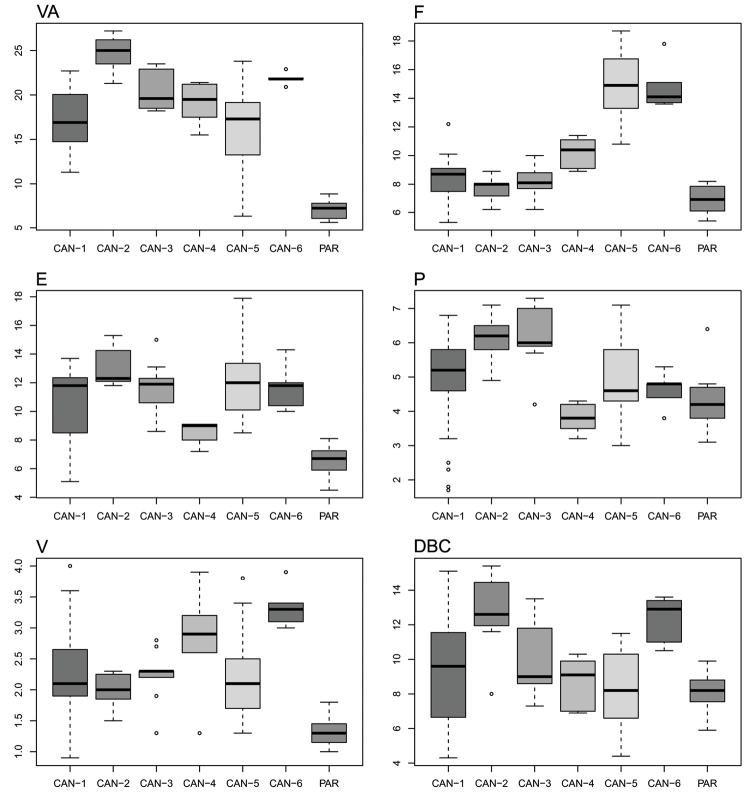
Box plots for genitalia characters of the seven Monacha clades investigated. The lower and upper limits of the rectangular boxes indicate the 25th to 75th percentile range, and the horizontal line within the boxes is the median (50th percentile).